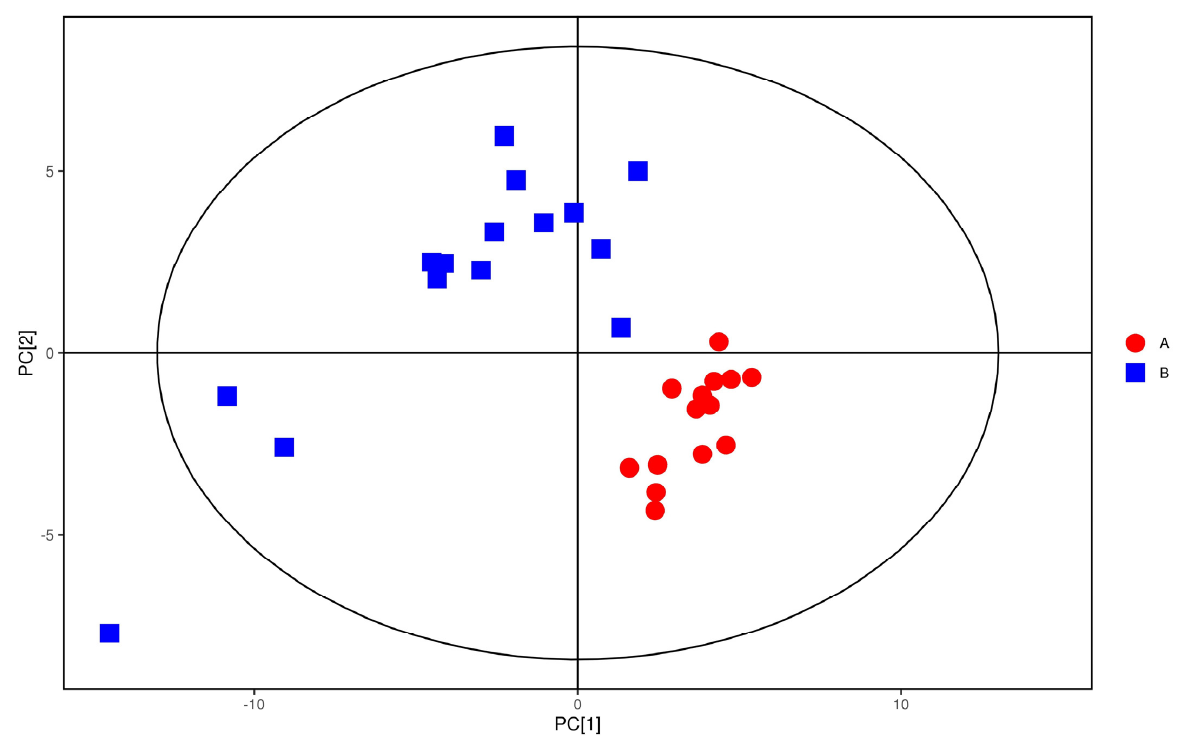
Figure 7. PCA score of anions. Red dots represent the control group. Blue dots represent the study